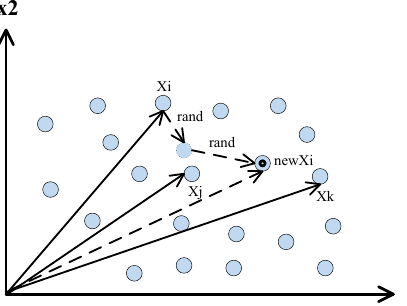
Figure 4. Two-dimensional example showing the process of the free walking path of elements.